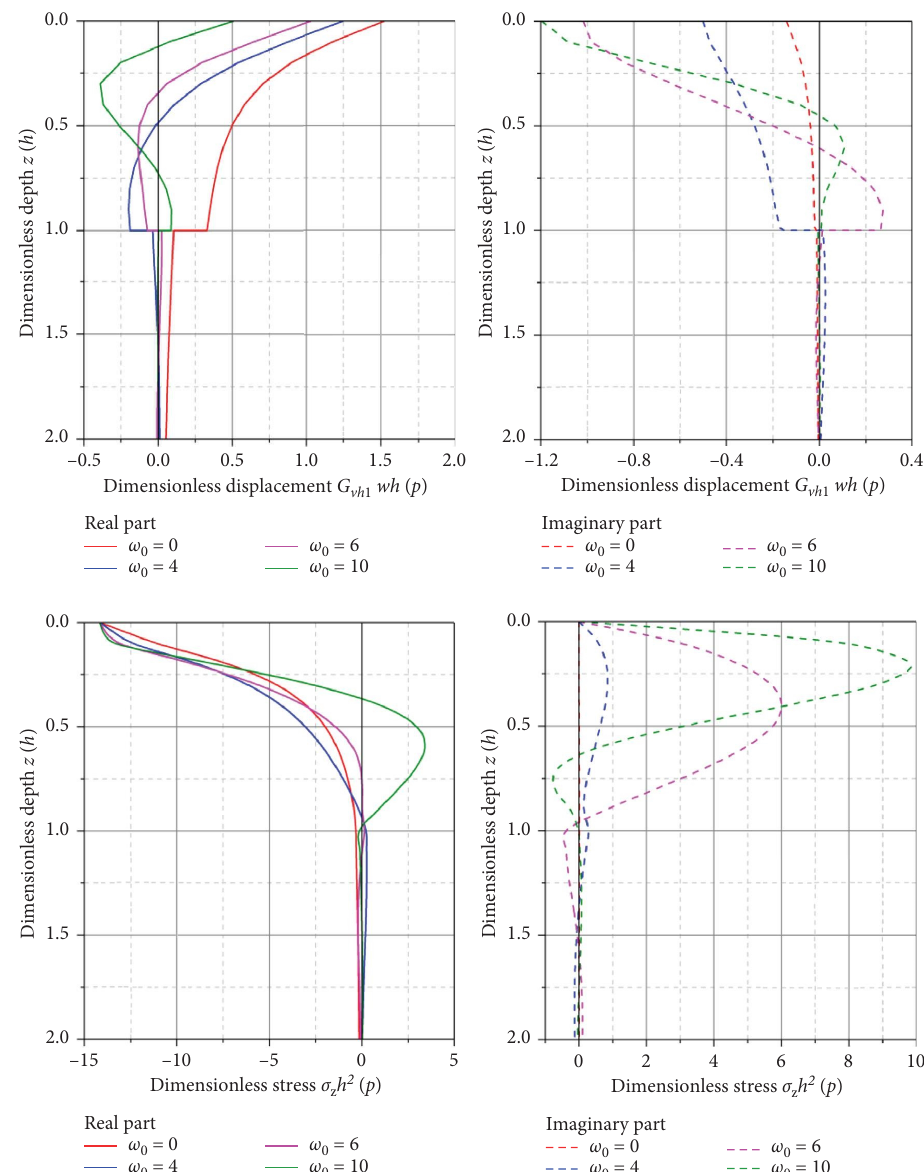
Figure 13: Te real and imaginary parts of the vertical displacement and the vertical stress versus the dimensionless depth at diferent dimensionless load r values of 0.5 h and h, respectively. Te trend of the variation Figures 15 and 16 illustrate the distributions of the vertical in the displacement and stress responses of the surface of the displacement of and the vertical stress on the surface of the medium at r values of 0.5 h and h is similar to the one at r � 0. layered medium in a dimensionless frequency range of 0–10 at